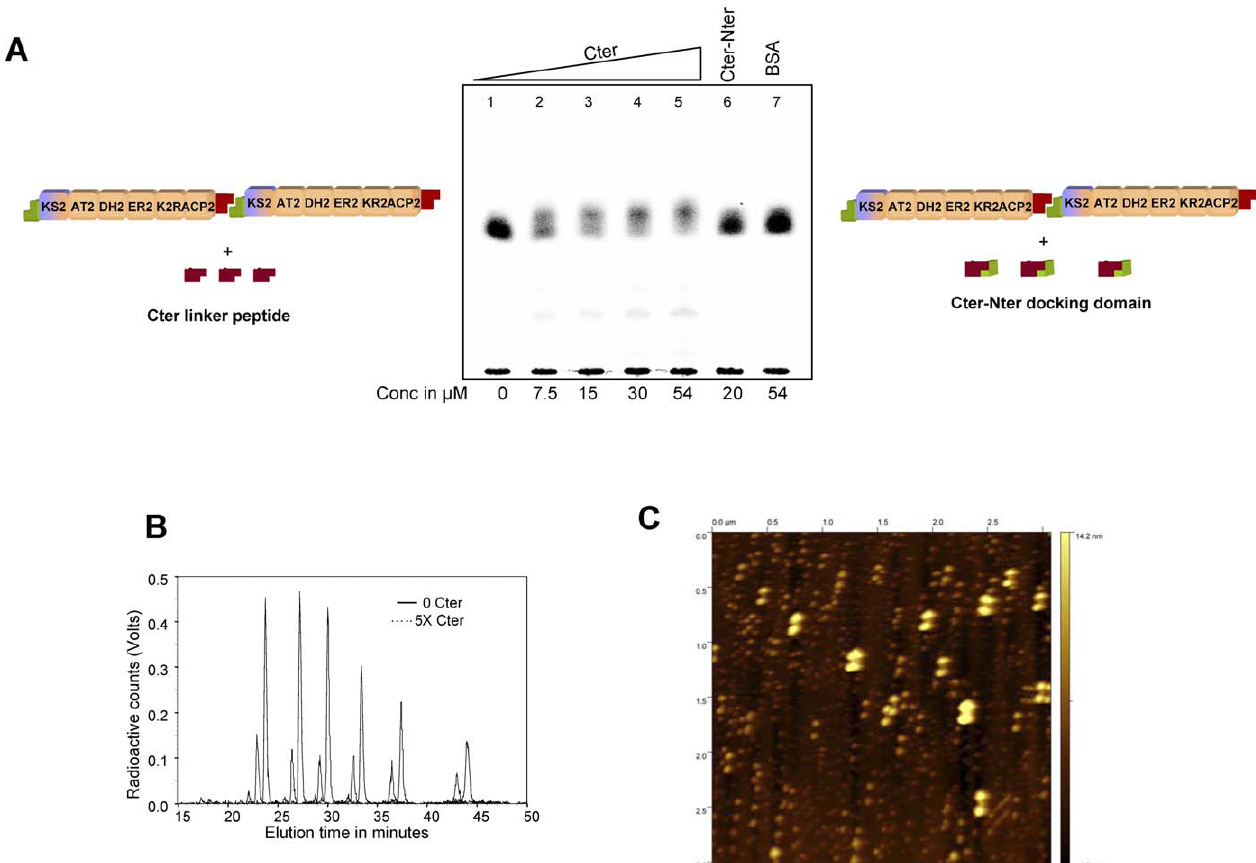
Figure 8. Effect of Cter Peptide on PKS12 D 1 Catalysis and AFM Analysis of PKS12 D 1 (A) Effect of Cter peptide, Cter-Nter concatenated peptide, and BSA on PKS12 D 1 catalysis. Specific inhibition of enzymatic activity by C-ter peptide can be seen from lanes 1 to 5. C-terminus peptide competes with other PKS12 D 1 molecules and thus specifically inhibits product formation. BSA and the concatenated C- and N-ter linker, which in itself forms a stable docking complex, does not interfere with PKS12 D 1 catalysis. (B) Radio-HPLC analysis of PKS12 D 1 reaction inhibited by five times molar excess of Cter peptide. The solid curve indicates the control run without any Cter peptide, and the dotted curve shows the profile for inhibited assay. (C) AFM analysis of PKS12 D 1 showing multimeric